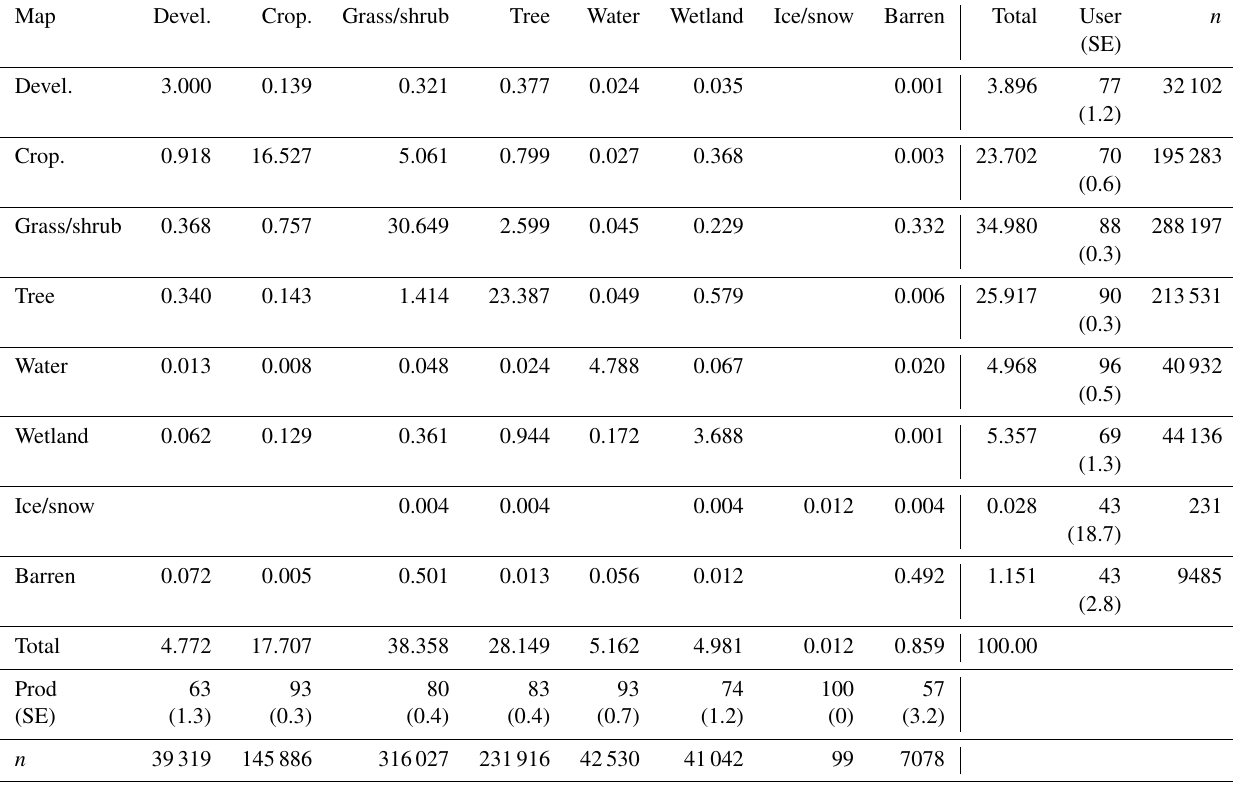
Table 3. Confusion matrix for CONUS (all years combined) where cell entries represent percent of CONUS area. Overall accuracy is 82.5% ( ± 0 . 22%). Standard errors for user’s and producer’s accuracies are shown in parentheses and n is the number of sample pixels for each row and column. Map